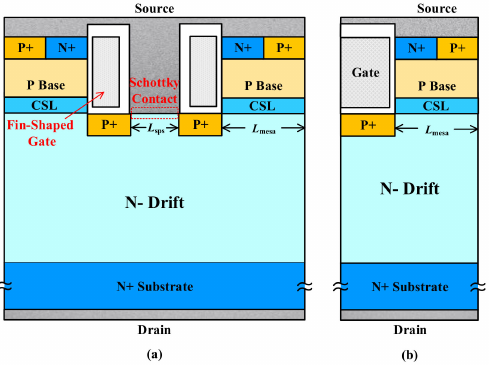
Figure 1. Cross-section view of ( a ) FS-TMOS (cell pitch) and ( b ) C-TMOS (half-cell